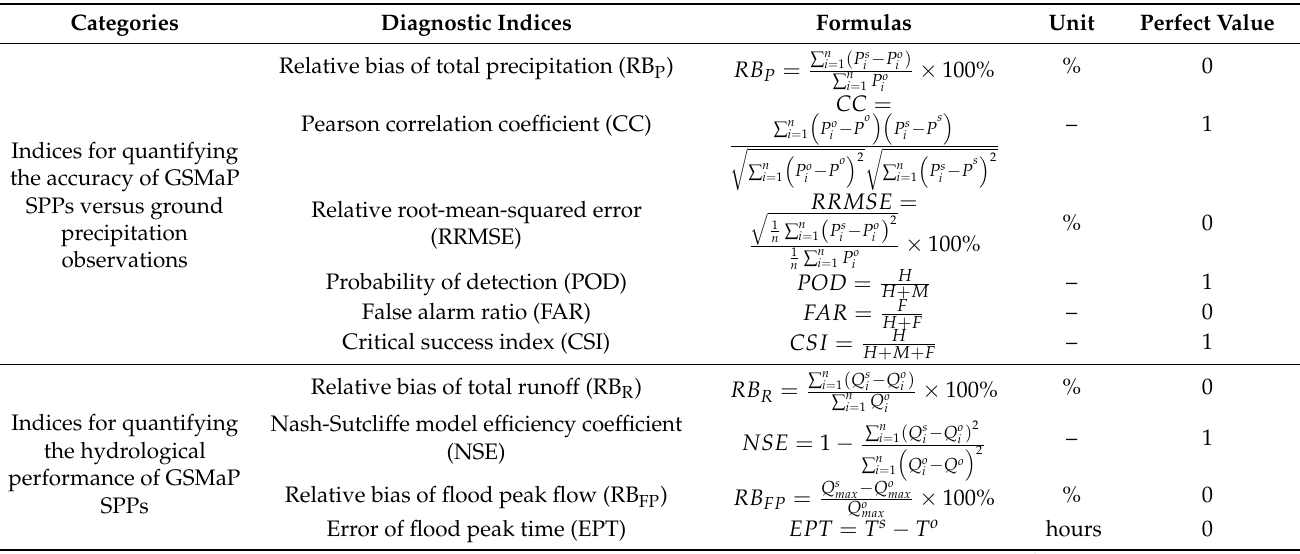
Table 2. Diagnostic indices for statistical and hydrological evaluations of